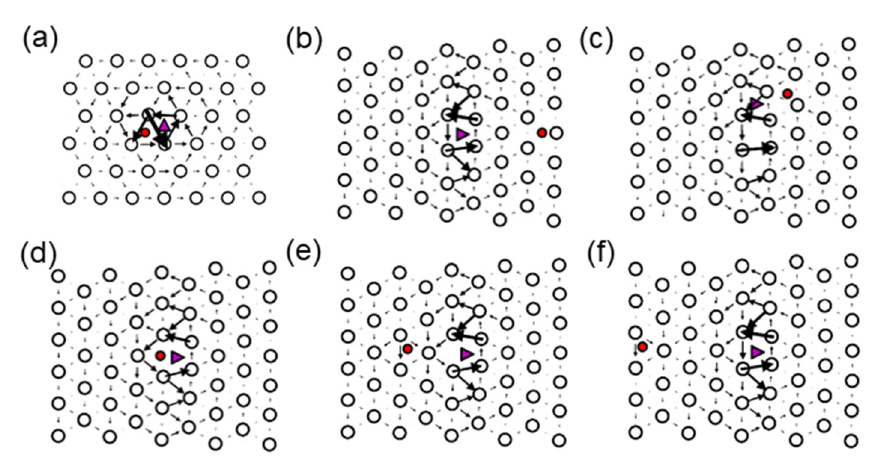
Figure 8. The locations of H sites ( a ) in the computational cell with two ½<111> screw dislocations, ( b – f ) corresponding to the sites from − 2 to 2 from Figure 3b in the cell with two mixed 111 dislocations. The location of the dislocation core is marked as a purple triangle; the final positions of H after the optimisation are shown as the red circles. The [111] component of the relative displacement of the neighboring atoms produced by the dislocation is depicted as an arrow between them.